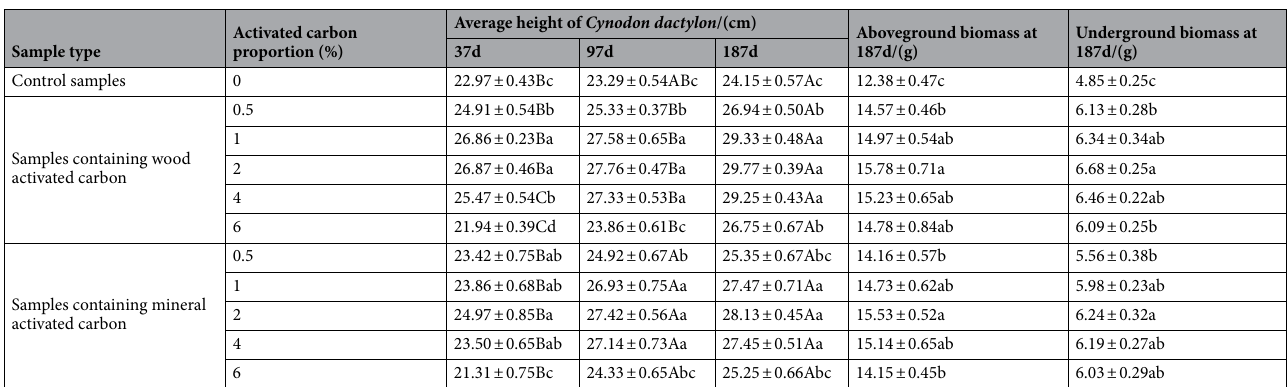
Table 4. Average plant height at different times and above/underground biomass at 187 d. Different capital letters indicate significant differences between different times ( P < 0.05). Different small letters indicate significant differences between different activated carbon proportions ( P <